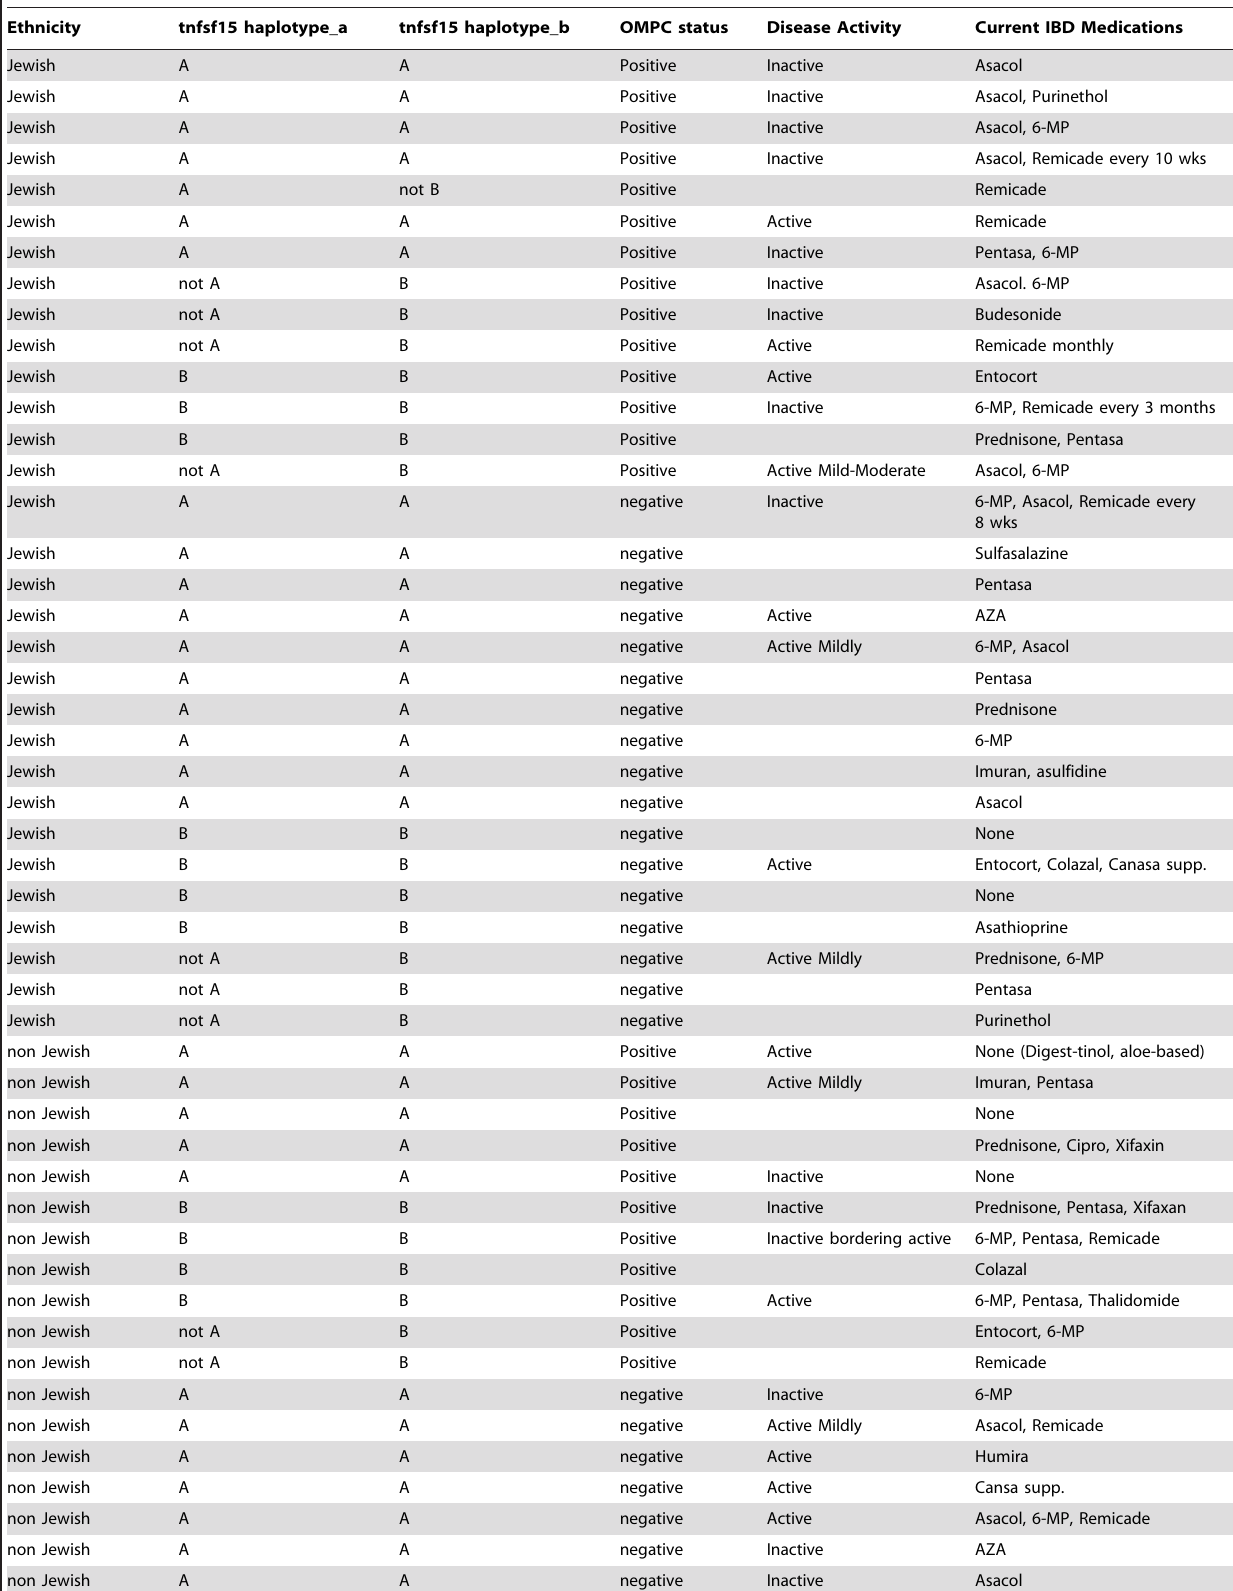
Table 1. Patient’s demographic, diagnoses, medications.